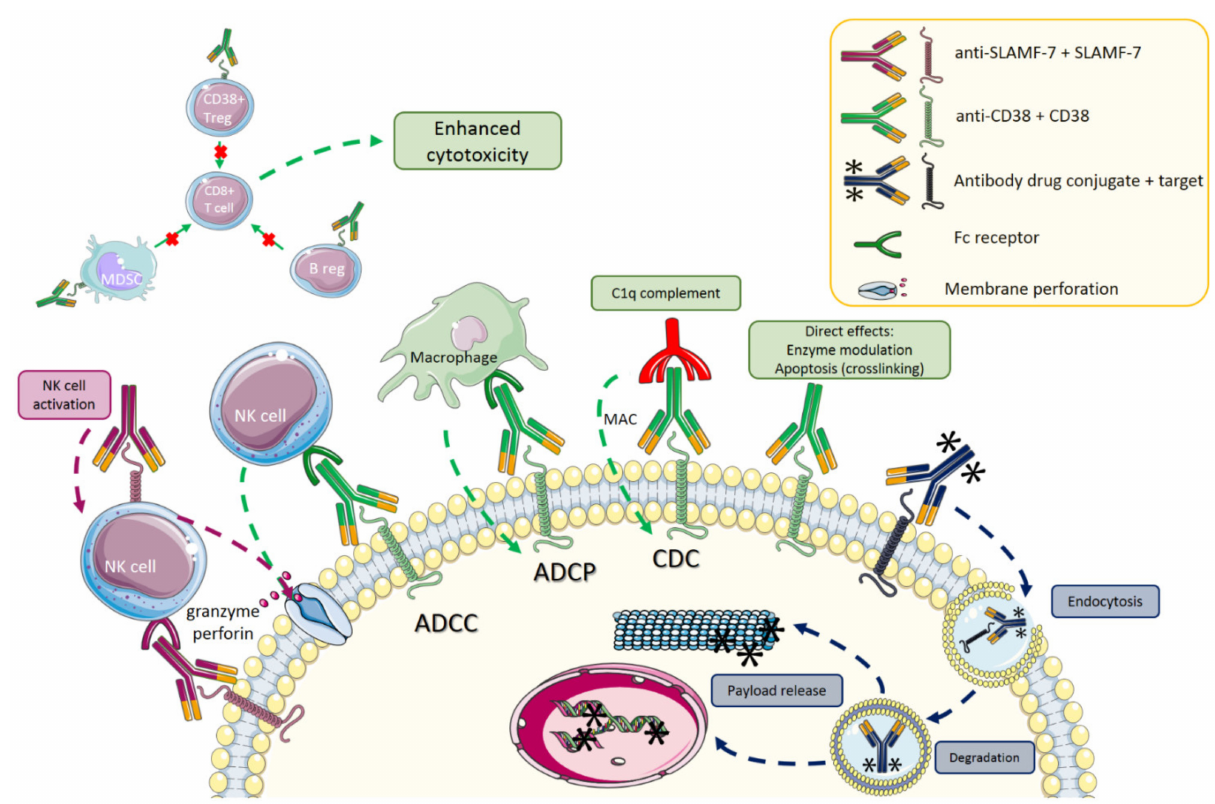
Figure 1. Mechanism of action of different naked antibodies and antibody drug conjugates. Effects of SLAMF-7 in purple, CD38 in green, and antibody drugconjugates (ADC) dark blue. Abbreviations: MDSC: myeloid-derived suppressor cells, NK: natural killer, Treg: regulatory T cell, B reg: regulatory B cell, ADCC: antibody dependent cellular cytotoxicity, ADCP: antibody dependent cellular phagocytosis, CDC: complement dependent cytotoxicity, MAC: membrane attacking complex. Images used from Servier Medical Art (available at https://smart.servier.com/, accessed date 20 February 2021, licensed under a Creative Commons Attribution 3.0 Unported License (CC BY 3.0, https://creativecommons.org/licenses/by/3.0/ accessed date 20 February